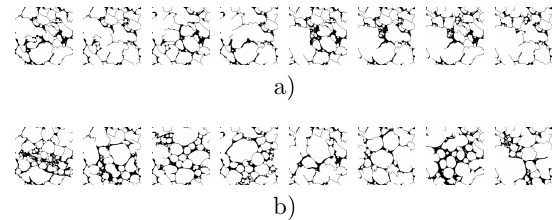
Figure 11. Wang tile set W8/2-2, tile size h = 2000 px, overlap ω = 200 px, a) raw tiles, b) patched tiles.